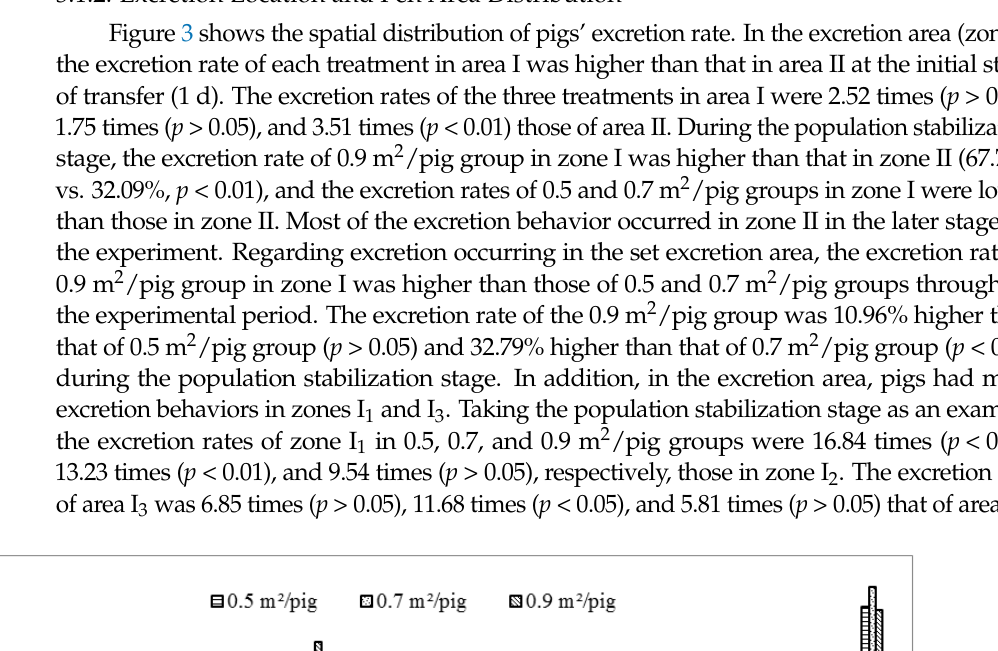
Figure 3. Spatial distribution of excretion rate of pigs with different stocking densities.